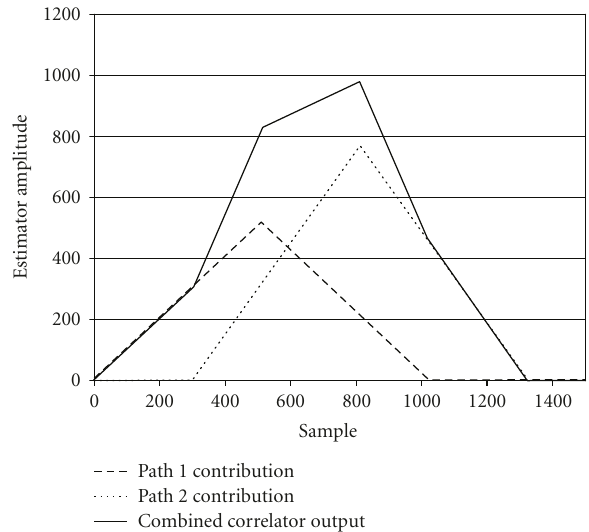
Figure 1: Summed correlation function for two-path